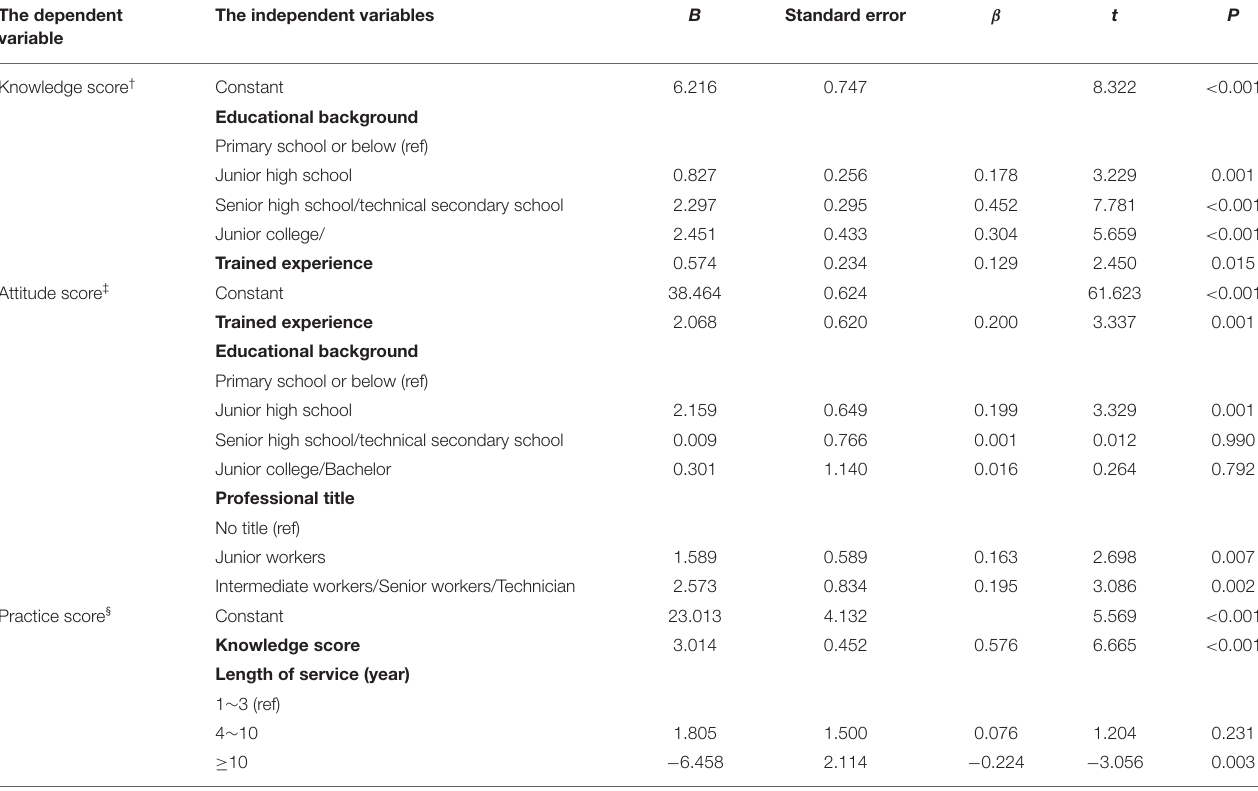
TABLE 5 | Multiple linear regression analysis on influencing factors of physical restraint knowledge, attitude, and practice of nursing staff. The dependent